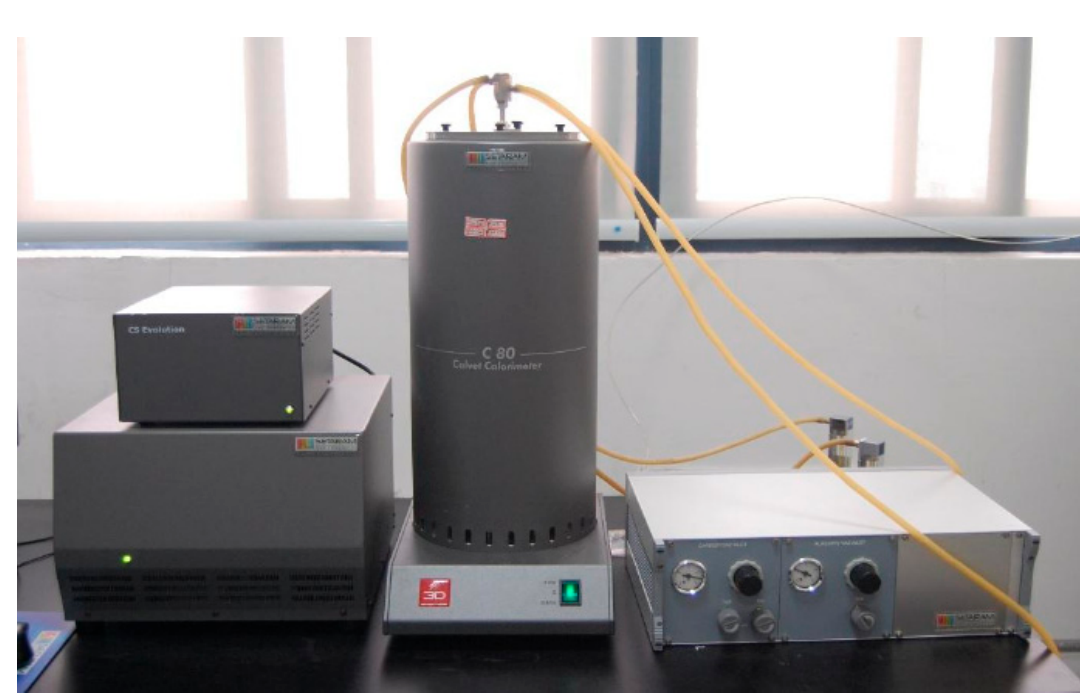
Figure 1. C80 micro-calorimeter.